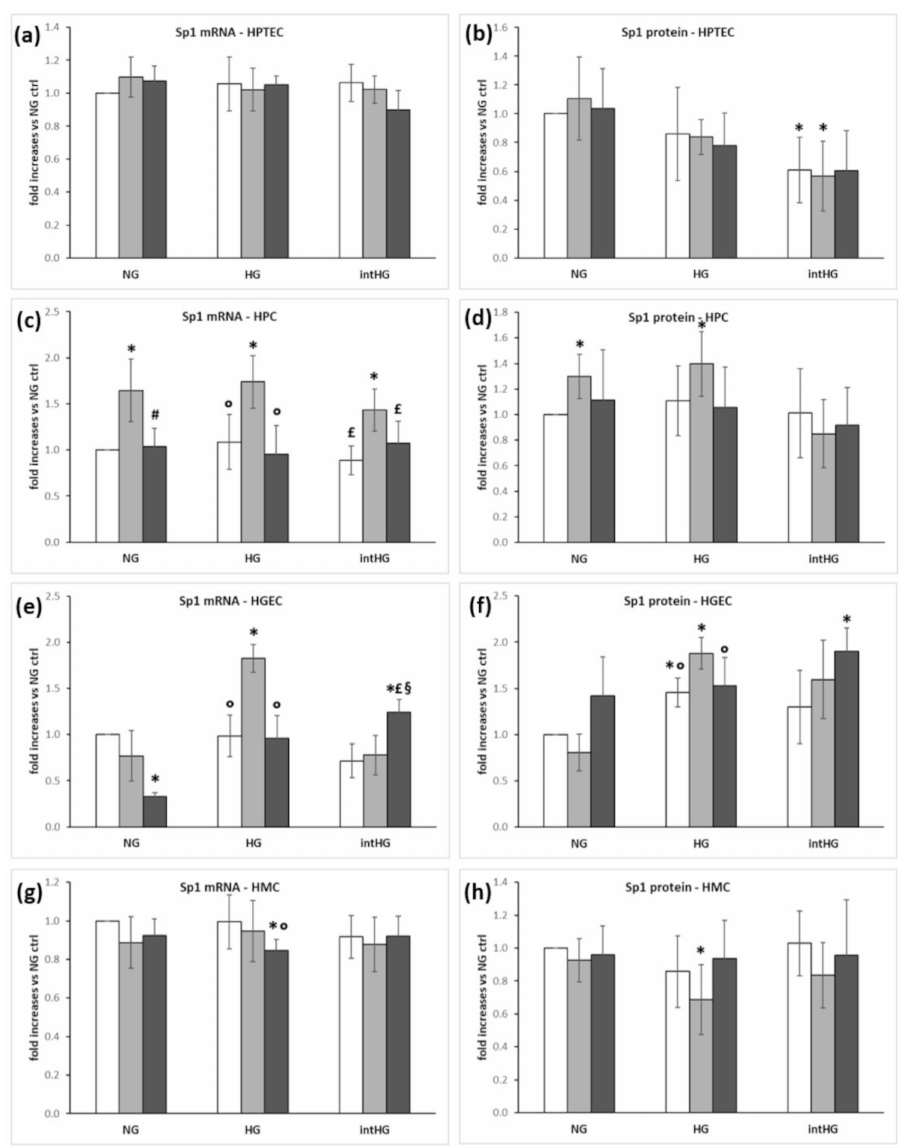
Figure 5. Sp1 expression in renal glomerular cells under different experimental conditions. ( a ) Sp1 mRNA and ( b ) protein expression in HPTEC; ( c ) Sp1 mRNA and ( d ) protein expression in HPC; ( e ) Sp1 mRNA and ( f ) protein expression in HGEC; ( g ) Sp1mRNA and ( h ) protein expression in HMC. White bars: physiological thiamine concentrations (ctrl); light grey bars: thiamine-deficient medium (TD); dark grey bars: high thiamine concentrations (HT). NG = physiological glucose concentrations; HG = high glucose concentrations; intHG = intermittent high glucose concentrations. Mean of 5 experiments ± SD. * p < 0.05 vs. NG ctrl; # p < 0.05 vs. NG TD; ◦ p < 0.05 vs. HG TD; £ p < 0.05 vs. intHG TD; § p < 0.05 vs. intHG